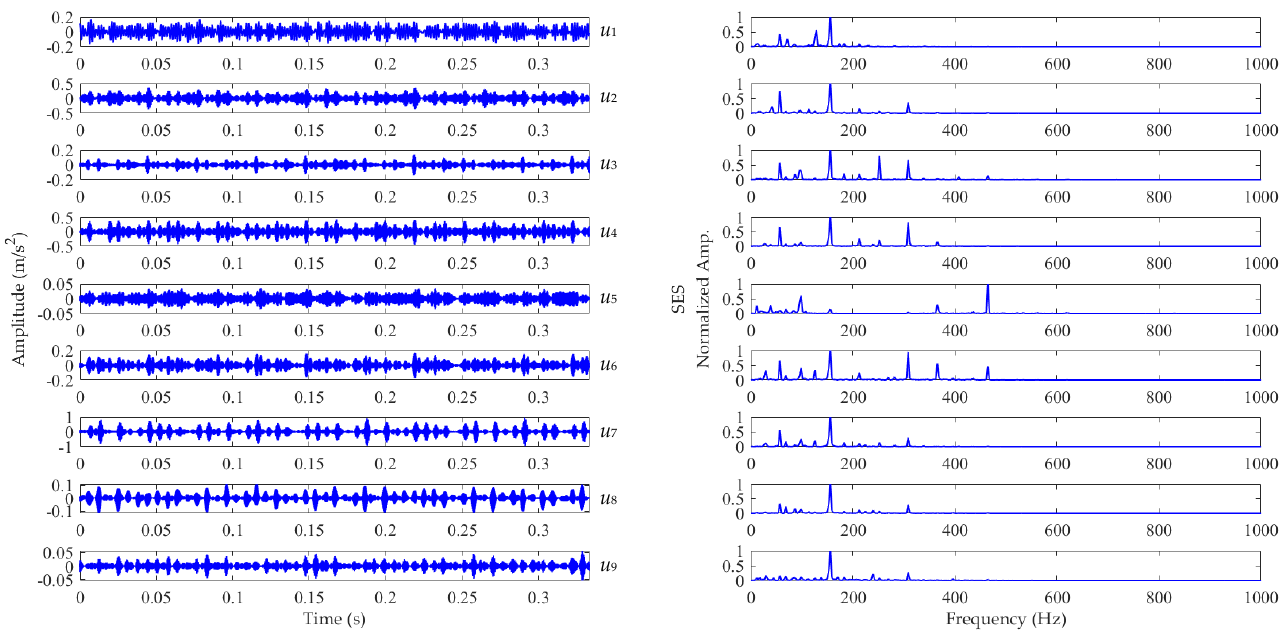
Figure 14. The EP index of each mode.